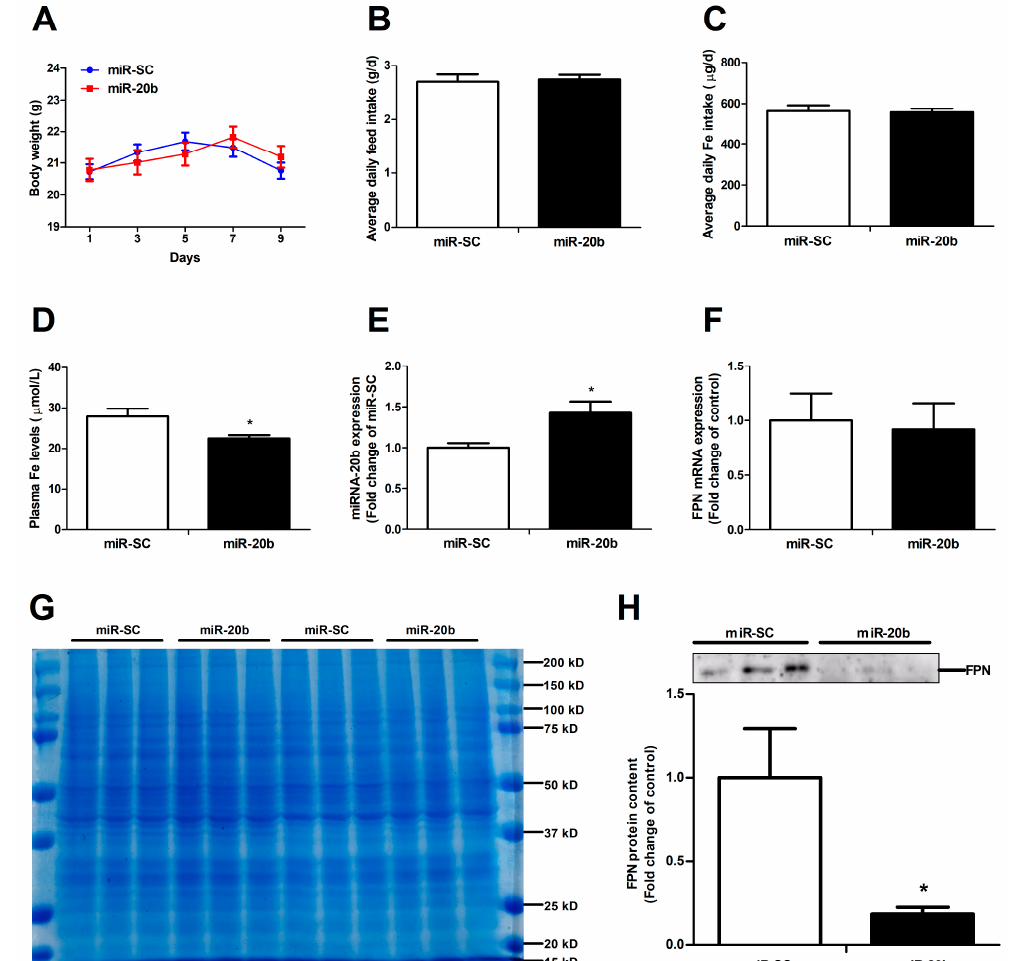
Figure 6. MiR-20b regulates endogenous FPN expression in vivo. ( A ) Body weight was calculated every two days. ( B , C ) Average daily feed intake and average daily iron intake throughout the feeding period. ( D ) Plasma iron level was measured by an automatic biochemical analyzer. ( E ) Expression of miR-20b in the duodenum of mice was analysed by qRT-PCR. ( F ) The mRNA expression of FPN was evaluated by qRT-PCR. ( G ) Coomassie brilliant blue (CBB) staining ensures that equal amounts of duodenal protein samples are loaded onto the gel. ( H ) FPN protein expression was analyzed by western blot. Values were expressed as means ± SEM, n = 15 in each group for Figure 6A–D, n = 6 in each group for Figure 6E–H, * p <